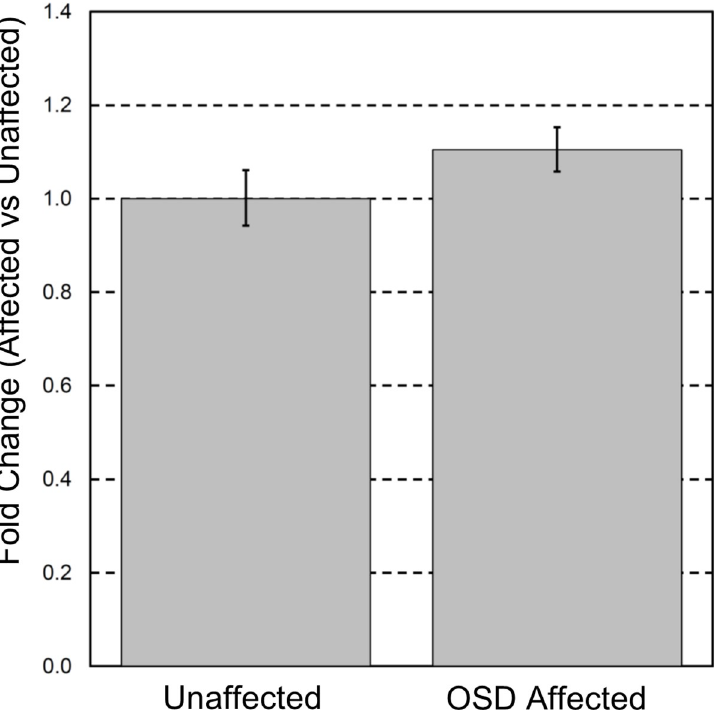
Fig 7. Effect of COL9A3 variant on mRNA. Quantitative RT-PCR: Expression of COL9A3 transcript is not significantly altered {Fold change = +1.1; measured by qRT-PCR in an oculoskeletal (OSD)-affected Northern Inuit Dog (NID) and unaffected non-NID}. Error bars show the standard deviation of technical triplicates.